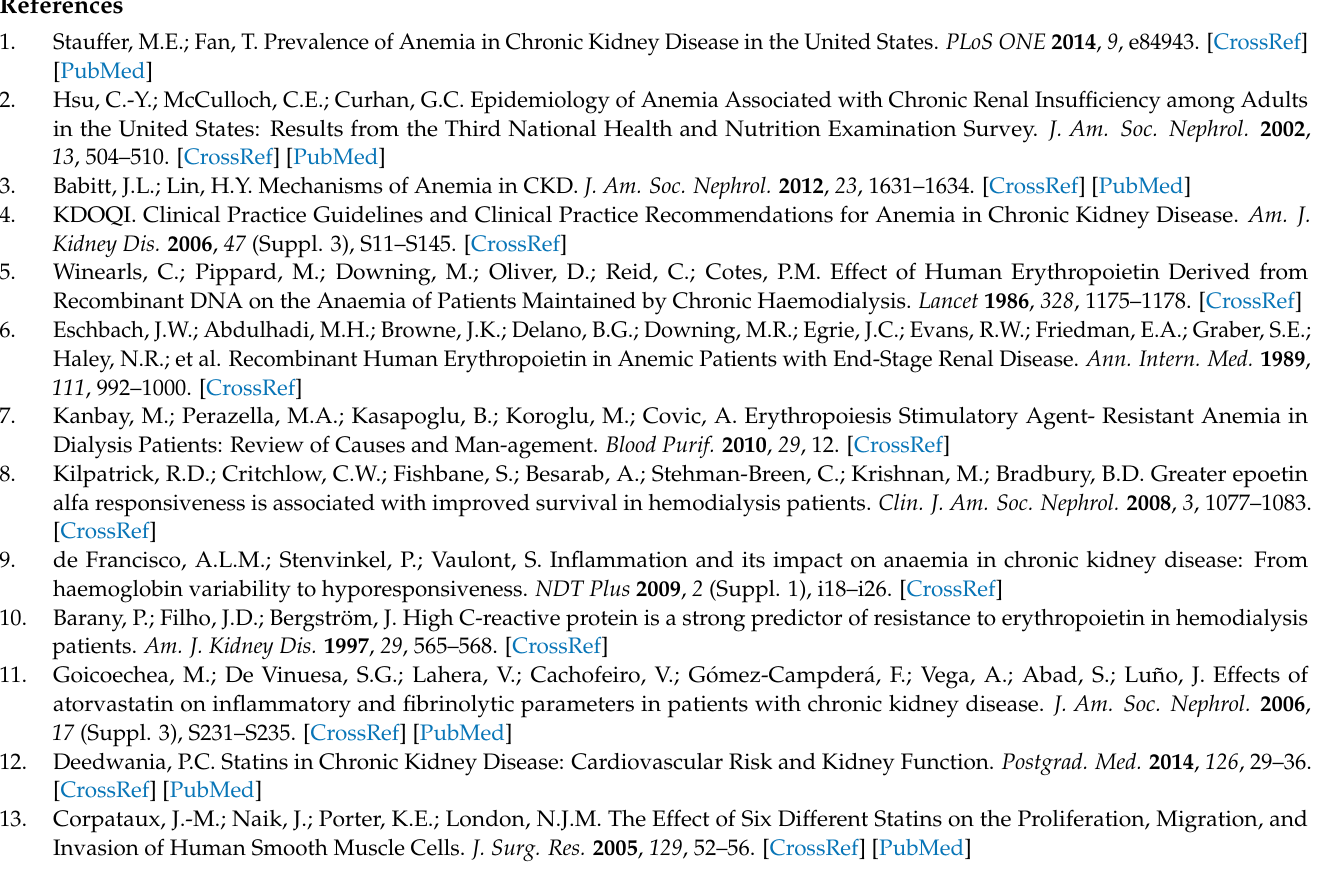
point., Figure S2: Hemoglobin – Single-arm., Figure S3: Hemoglobin – Change-from-baseline